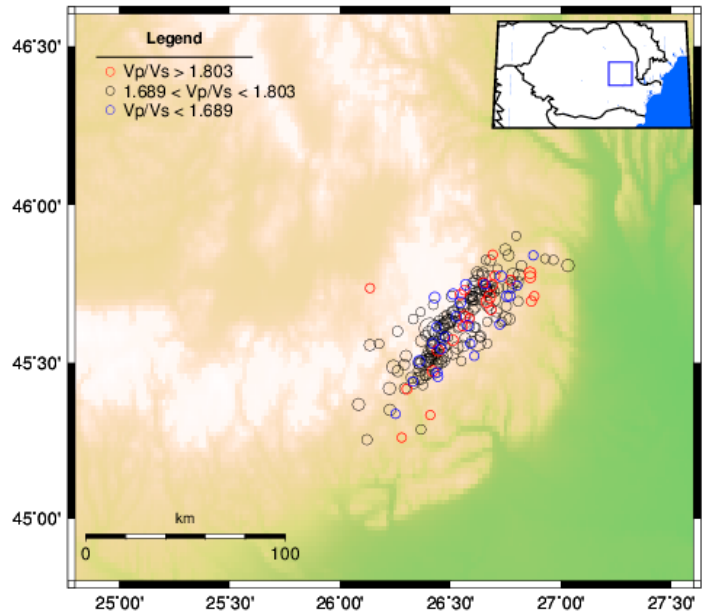
Figure 10. Vp/Vs distribution associated with selected subcrustal earthquakes (M L ≥ 2.5) that occurred in the Vrancea region from 1 April 2018 to 30 April 2019. The size of the symbols is proportional to the magnitude of the earthquake. The inset shows the location of the study region on the map of Romania.